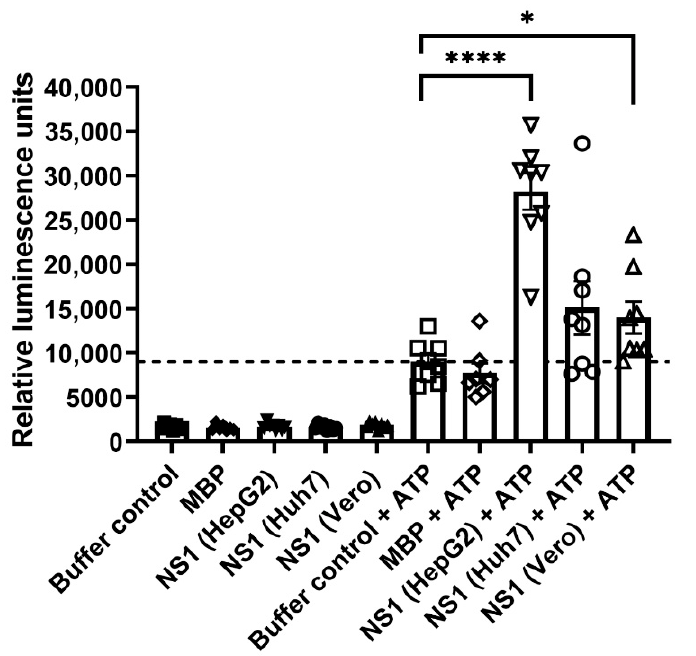
Figure 3. Kinase activity of DENV NS1 derived from different cell types. Extracellular NS1 proteins (0.5 µg) prepared from DENV-infected HepG2, Huh7, and Vero cell cultures were subjected to a kinase assay to determine their kinase activity in the presence or absence of ATP. Reactions that had no DENV NS1 (buffer control) or that contained myelin basic protein (MBP) served as a baseline control and an unrelated protein control (no kinase activity) in the assay, respectively. Kinase activity is presented in relative luminescence units. The results show the mean ± the standard error of the mean (SEM) of eight independent experiments. The dotted line represents the mean baseline level of buffer control in the presence of ATP. Differences in relative luminescence units between DENV NS1 derived from each cell type and buffer control in the presence of ATP were analyzed by an unpaired t -test (**** p < 0.0001, * p < 0.05).